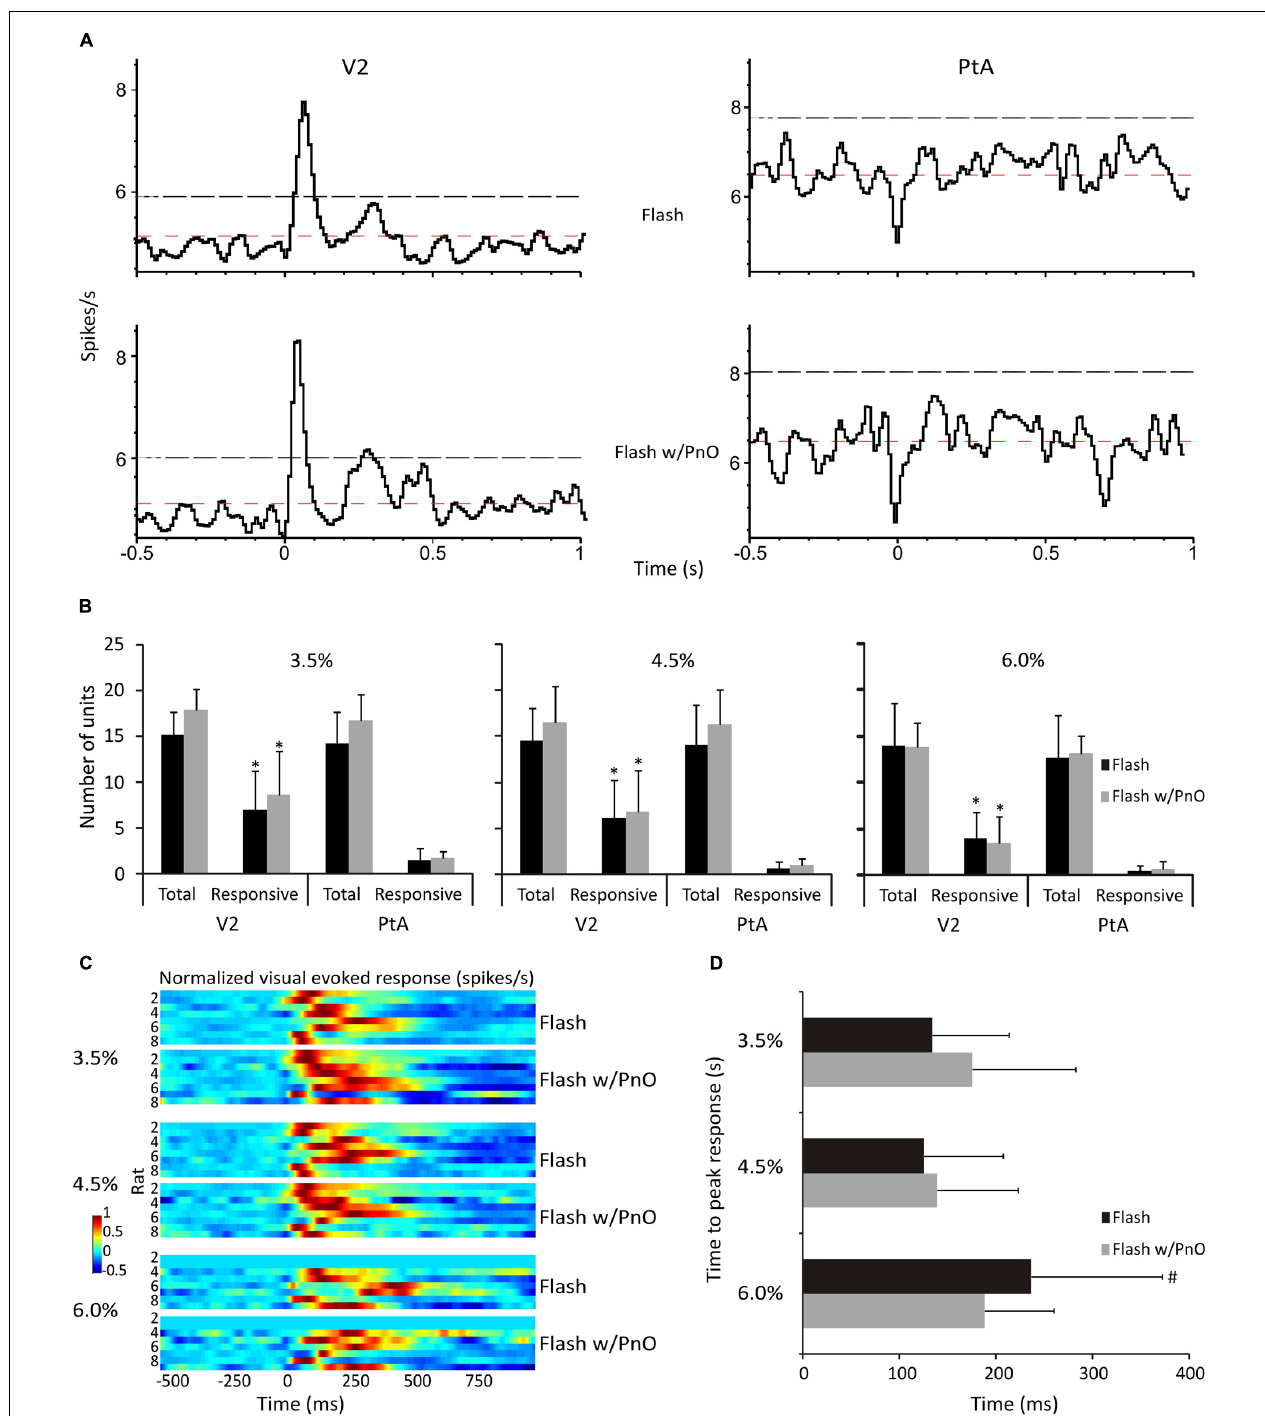
neurons responded to light flashes than those in PtA at all desflurane concentrations. (C) Visual evoked responses are displayed from responding V2 neurons in each rat to light flashes alone and paired with PnO stimulation. (D) The time to peak response was not altered by PnO stimulation. However, it took longer for V2 neurons to reach peak response at 6.0% desflurane. * p < 0.05 responding neurons in V2 vs. responding neurons in PtA. # p < 0.05 time to peak response at 6 vs. 4.5%. Error bars are ± 1